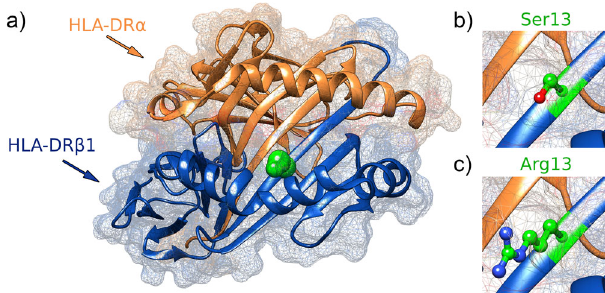
Fig. 1 Ribbon representation of the MHC class II molecule HLA-DR. The position 13 of the HLA-DR β 1 subunit is highlighted in green ( a ). A magni fi ed molecular representation of the residues conferring risk (serine) and protection (arginine) to Sertoli cell-only phenotype is also shown ( b ,